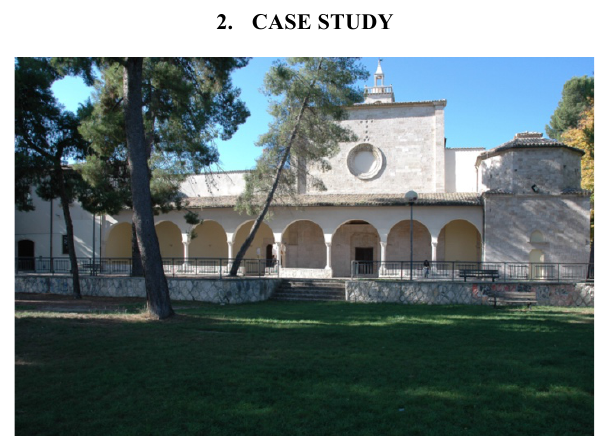
Figure 3. Main entrance of the Annunziata